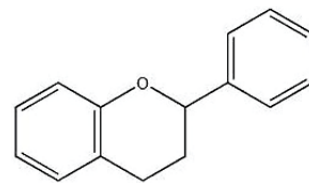
Figure 1. Basic chemical structure of a flavonoid.